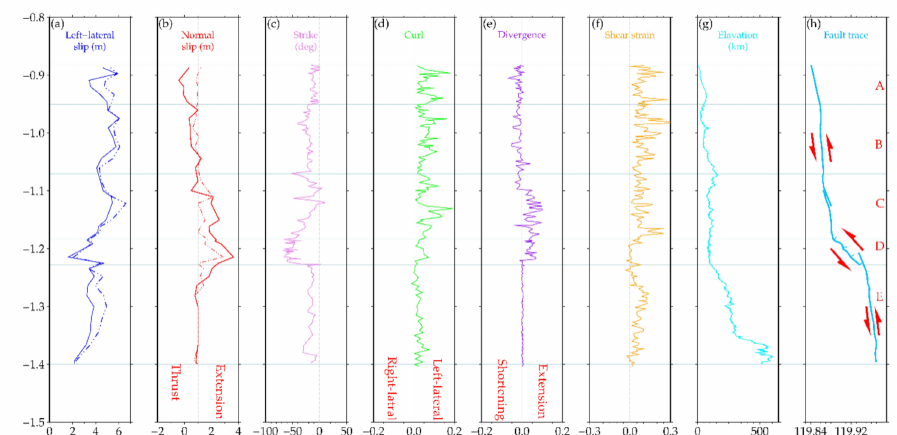
Figure 4. Geometric variation controlling surface rupture. ( a ) Left-lateral slip profiles and ( b ) normal slip profiles, where near-fault slip (solid lines) and total slip (dotted lines) are measured along a cross-fault profile (2 km swath along latitude). ( c ) Fault-strike azimuth; ( d ) curl ( ω ) profile extracted at the main fault, where positive ω at the fault corresponds to left-lateral strike-slip rupture; ( e ) divergence ( δ ) profile, where negative δ at the fault indicates shortening and positive δ indicates extension; ( f ) shear strain ( γ ) profile, where positive γ at the fault indicates rupture dominated by shear stress (left-lateral); ( g ) elevation; ( h ) fault trace. Geometric variation controlling surface rupture was identified according to the process shown in Figures